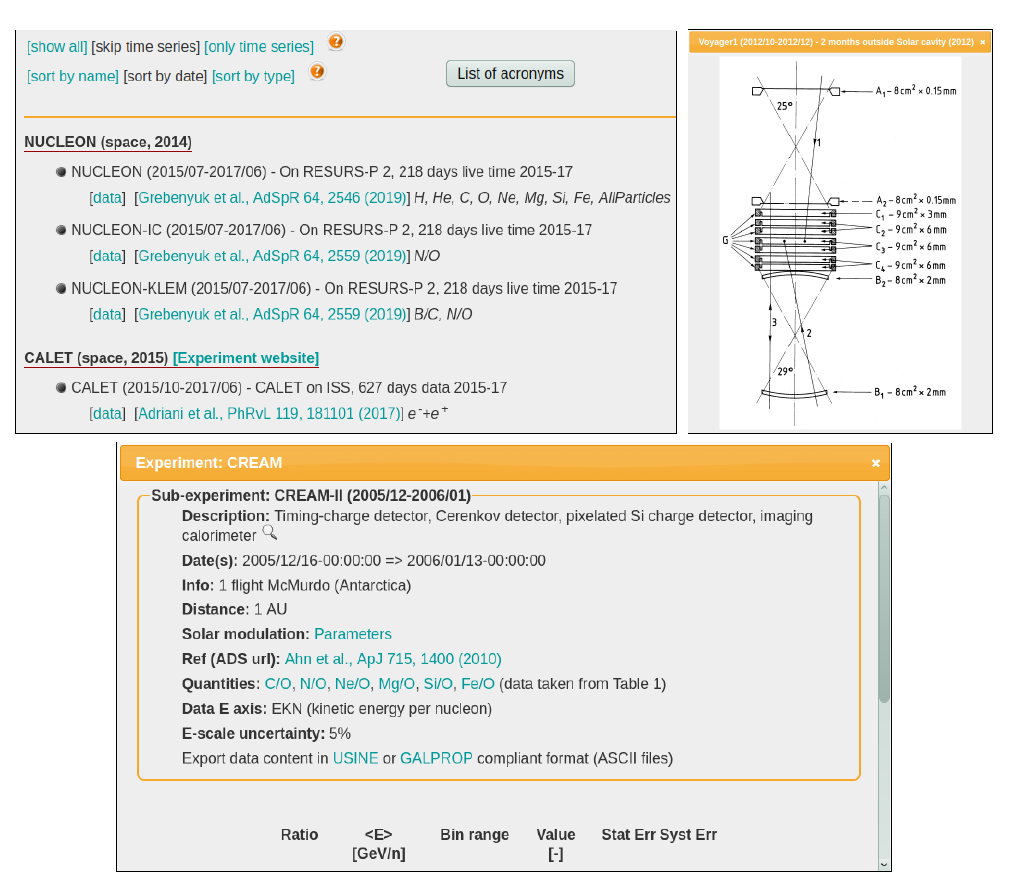
Figure 5. Snapshot from the E XPERIMENTS /D ATA tab illustrating how experiments, sub-experiments, and publication meta-data are organised in this tab ( top left panel ). From here, clicking on (i) the ‘List of acronyms’ button provides the meaning of acronyms for all experiments in CRDB (not shown), (ii) the magnifying glass icon (seen beside sub-experiment names) pops-up the detector schematics ( top right panel ) showing Voyager in this example, (iii) the ‘[data]’ link pops-up the full meta-data informations and associated data ( bottom panel